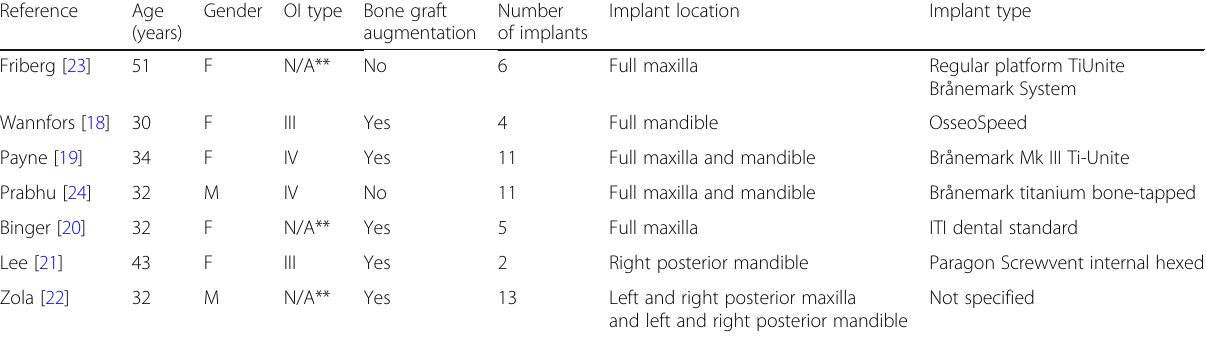
Table 3 Reported implant therapy for patients diagnosed with osteogenesis imperfecta Reference Age Gender OI type Bone graft Number Implant (years) augmentation of implants